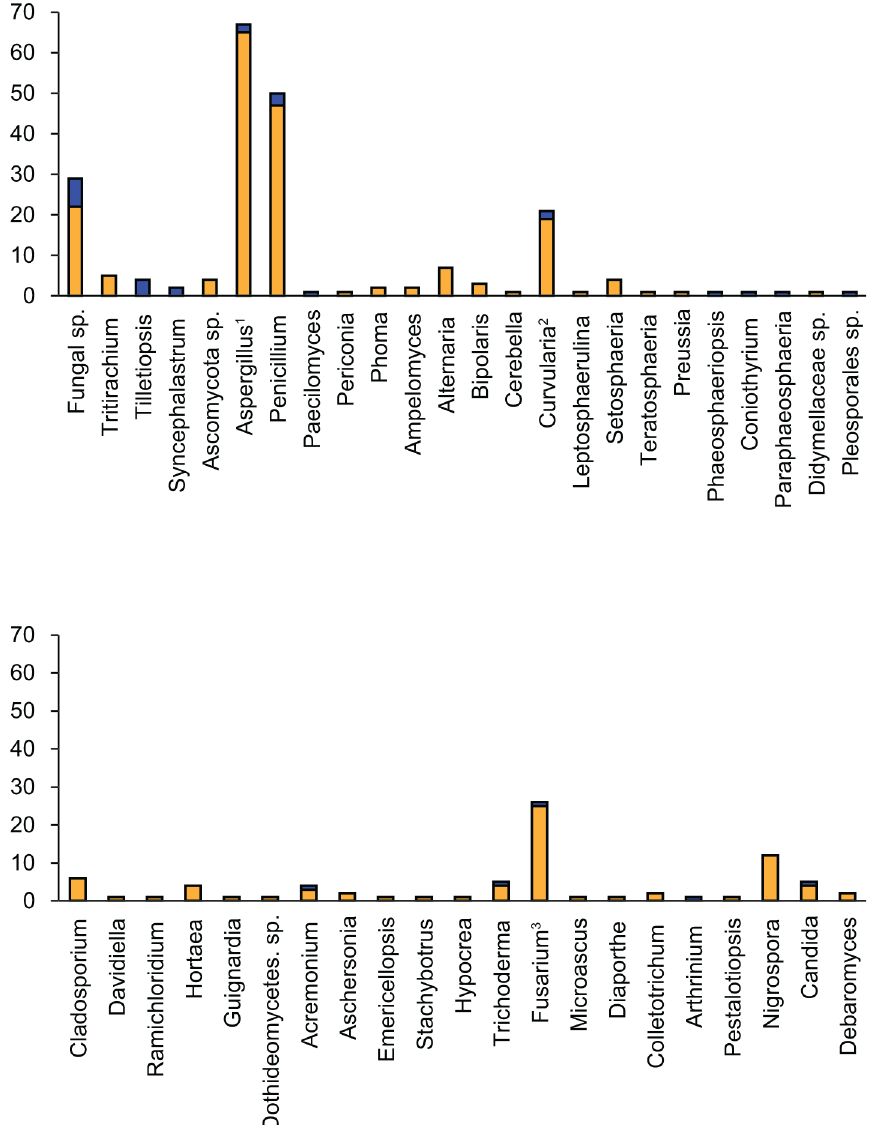
Fig 2. BLAST search results. Genus-level frequency distributions of isolates based on best BLAST matches for the barcodes produced in this study. The blue part of each bar corresponds to isolates that we classified as ‘ unknown ’ based on low percentage sequence identity with the best BLAST match and branch length in the phylogenetic tree (Figs 4, 5, 6 and 7). 1 Isolates with best BLAST match with the teleomorphs Eurotiales or Neosartorya are included. 2 Isolates with best BLAST match with the teleomorph Cochliobolus are included. 3 Isolates with best BLAST match with the teleomorph Gibberella are included.